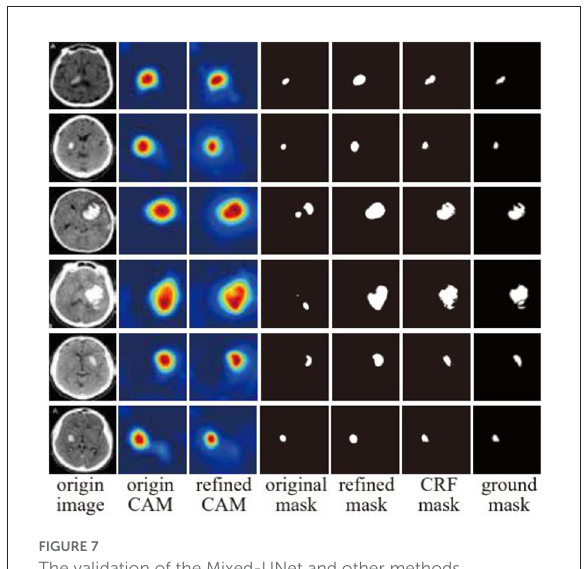
FIGURE7 The validation of the Mixed-UNet and other